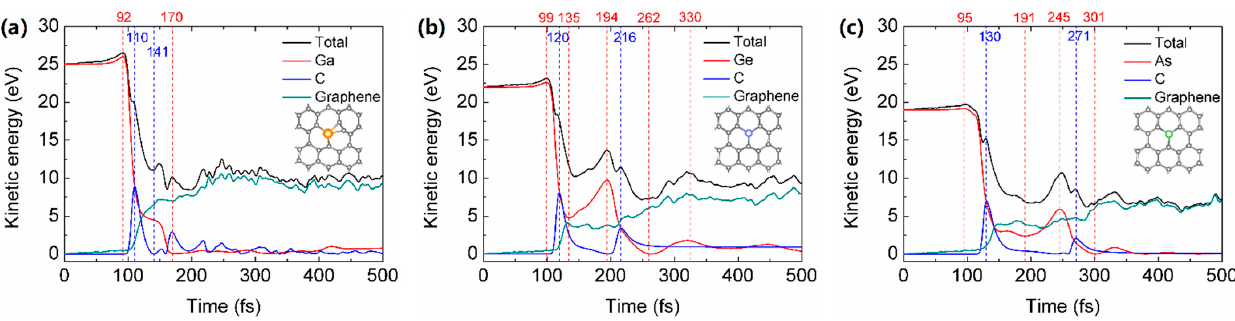
Figure 3. The kinetic energy transfer from the incident ( a ) 25 eV Ga, ( b ) 22 eV Ge and ( c ) 19 eV As atom (red line) to the impacted C atom (blue line) and graphene with 159 atoms (green line), as well as the total kinetic energy of the system with all 161 atoms (black line) as a function of time. The structure of Ga/Ge/As implanted graphene after 500 fs simulations is shown in the inset of ( a – c ), respectively. Table 1. The maximum values ( E max ) and minimum values ( E min ) of kinetic energy of the impacted C atom during and after collision, as well as the differences T d between E max and E min